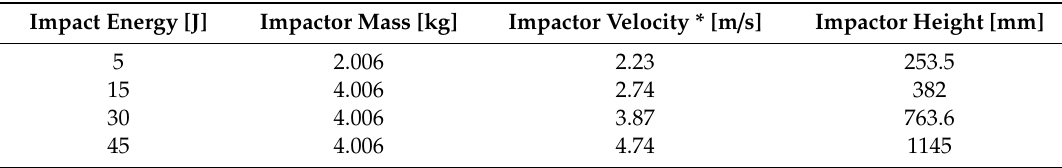
Table 2. Parameters of impact